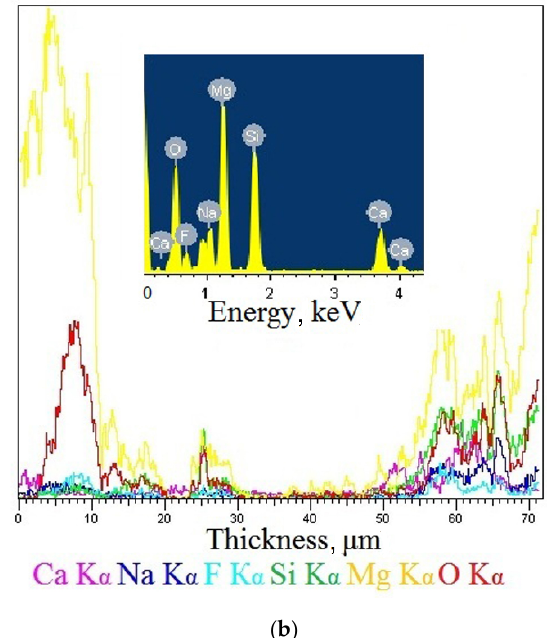
Figure 4. SEM image of the W-coating deposited at 450 V ( a ), element distribution maps ( b ), and the energy spectrum ( c ). The element distribution tracks along the cross-section of the coating are shown in